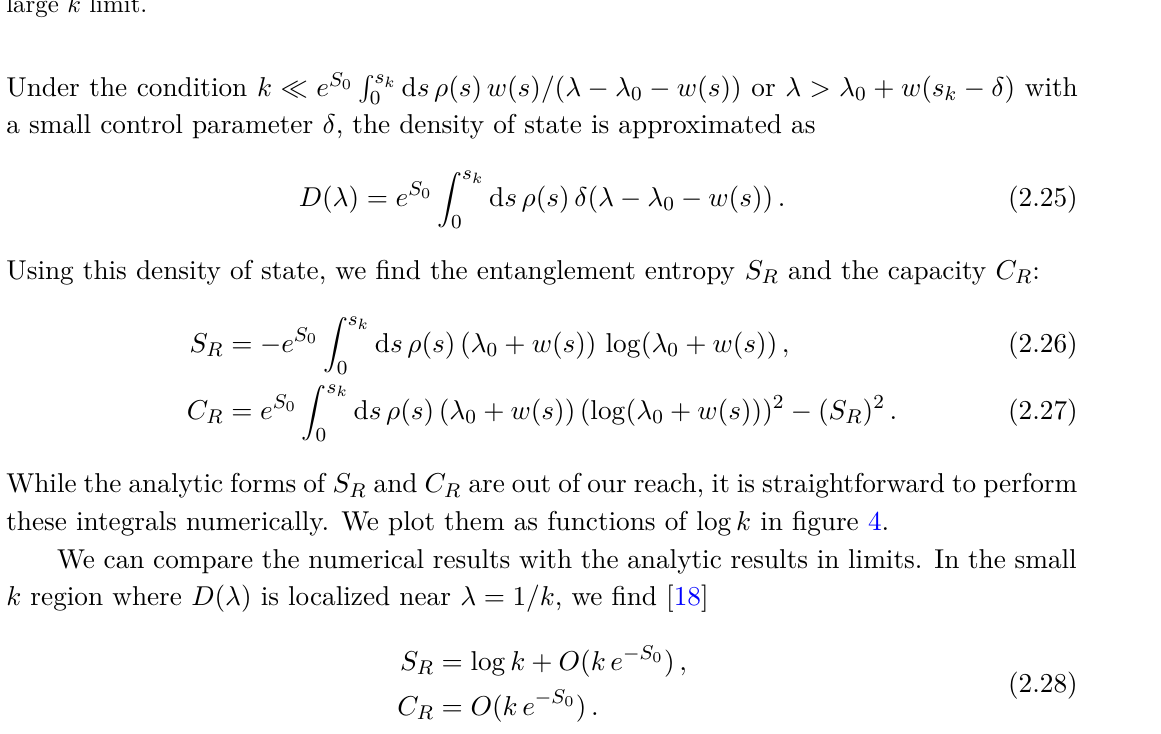
Figure 4 . The entropy (blue) and capacity (orange) of the EOW brane model in the canonical ensembles. Both approach the asymptotic values S BH and C BH shown in the dashed lines in the large k